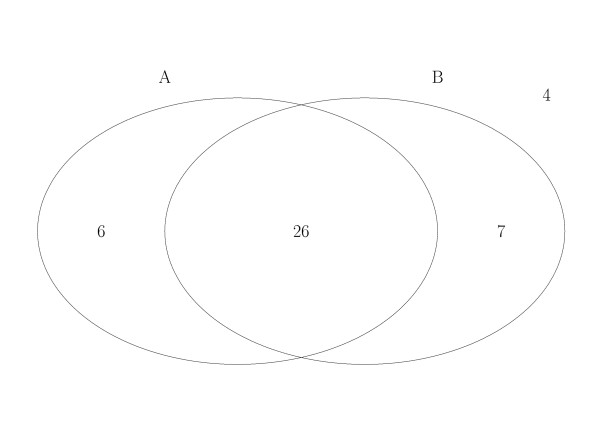
Predictions of AT excursion and BWS1. In this figure, the set A consists of origin replications predicted by the AT excursion method and B consists of those predicted by the BWS1 method. A ⋂ BC = {cehv71, cehv72, ehv41, hsv21, hsv22, hsv23}, AC ⋂ B = {cehv162, cehv163, ebv1, ebv3, hhv6, hhv6b, rcmv}, (A ⋃ B)C = {bohv4, ehv42, ehv43, hhv7}. The rest of the replication origins (26 of them) are predicted by both methods. Note that for viruses with several known replication origins, such as the hsv2, which has three (see Table 3), we denote the replication origins as hsv21, hsv22, hsv23, etc.